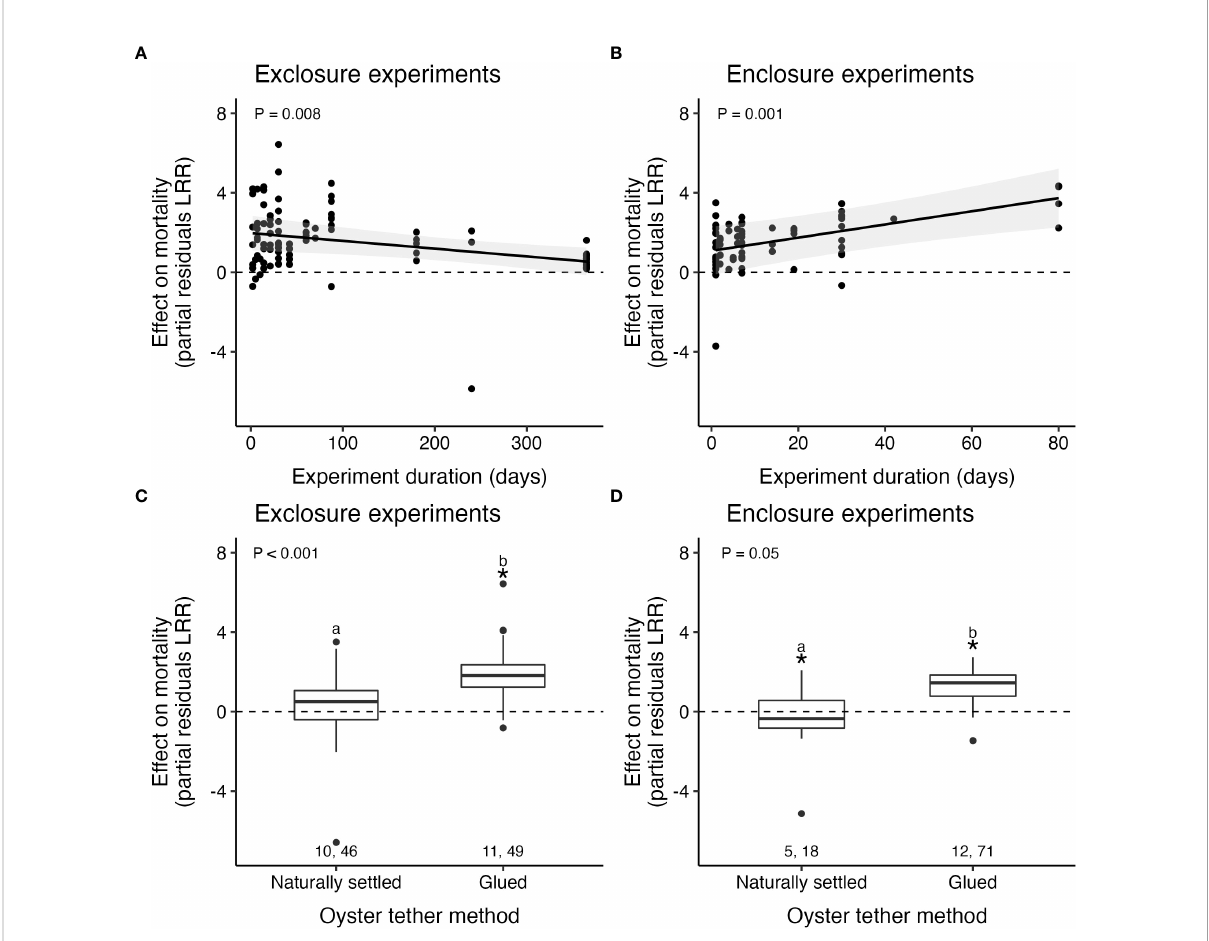
FIGURE 6 Predator effects on oyster mortality weakened as experiment duration increased in exclosures (A) , while the opposite pattern was detected in enclosure experiments (B) . Predators increased mortality in oysters tethered with glue relative to naturally settled individuals in both exclosure (C) and enclosure (D) experiments. For panels A and B, points show partial residuals, lines indicate the model-estimated predicted fi ts and shading displays 95% con fi dence intervals. Pairs of numbers, boxplots, asterisks, letters, and p-values as in Figure